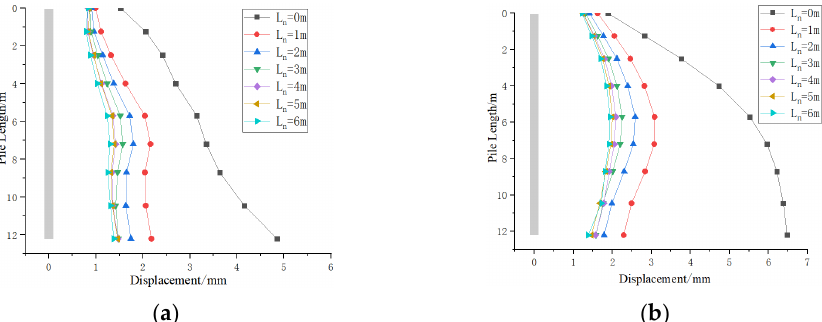
Figure 13. Comparison curve of thickness effect of grouting reinforcement with H = 12.2 m: ( a ) pile Z2; ( b ) pile Z3.